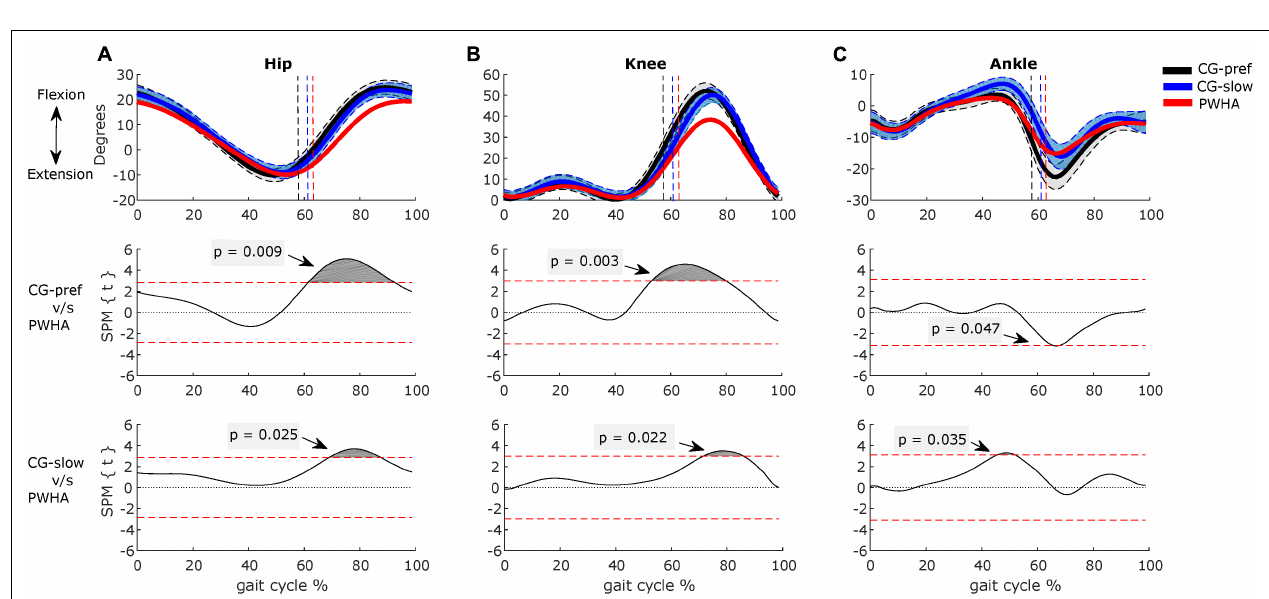
FIGURE 8 | Comparison between groups of kinematics during gait. (A) Hip. (B) Knee. (C) Ankle. (Top row) Kinematics of people with hemophilic arthropathy (PWHA; n = 14) at their preferred velocity (red), the control group ( n = 13) at their preferred velocity (CG-pref, black), and during the slow velocity condition (CG-slow, blue). Data are plotted as a function of normalized step time (0, heel strike) and expressed as mean with 95% confidence interval for CG. Vertical dashed lines indicate transition from stance to swing phase (black, CG-pref; blue, CG-slow; red, PWHA). (Bottom two rows) Time-dependent t values of the statistical parametric mapping (SPM) for groups comparison. Horizontal red dashed line indicates p = 0.05 level. Gray zones indicate regions with statistically significant differences. Data are expressed as mean and 95% confidence interval.